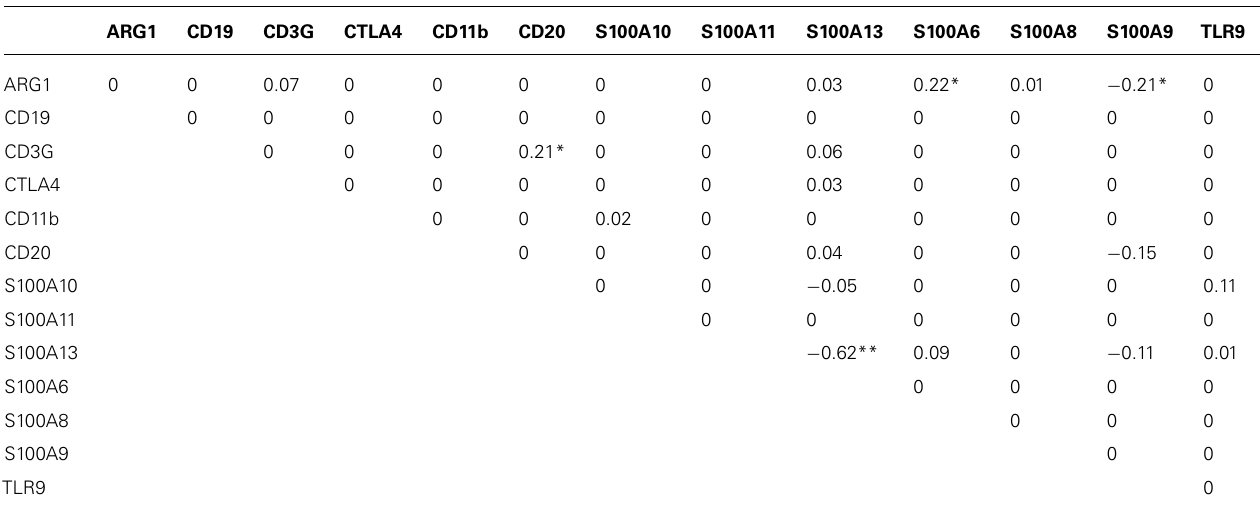
Table 1 | Elastic net regression analyses of gene–gene interaction between the HT and LT-T1D groups.